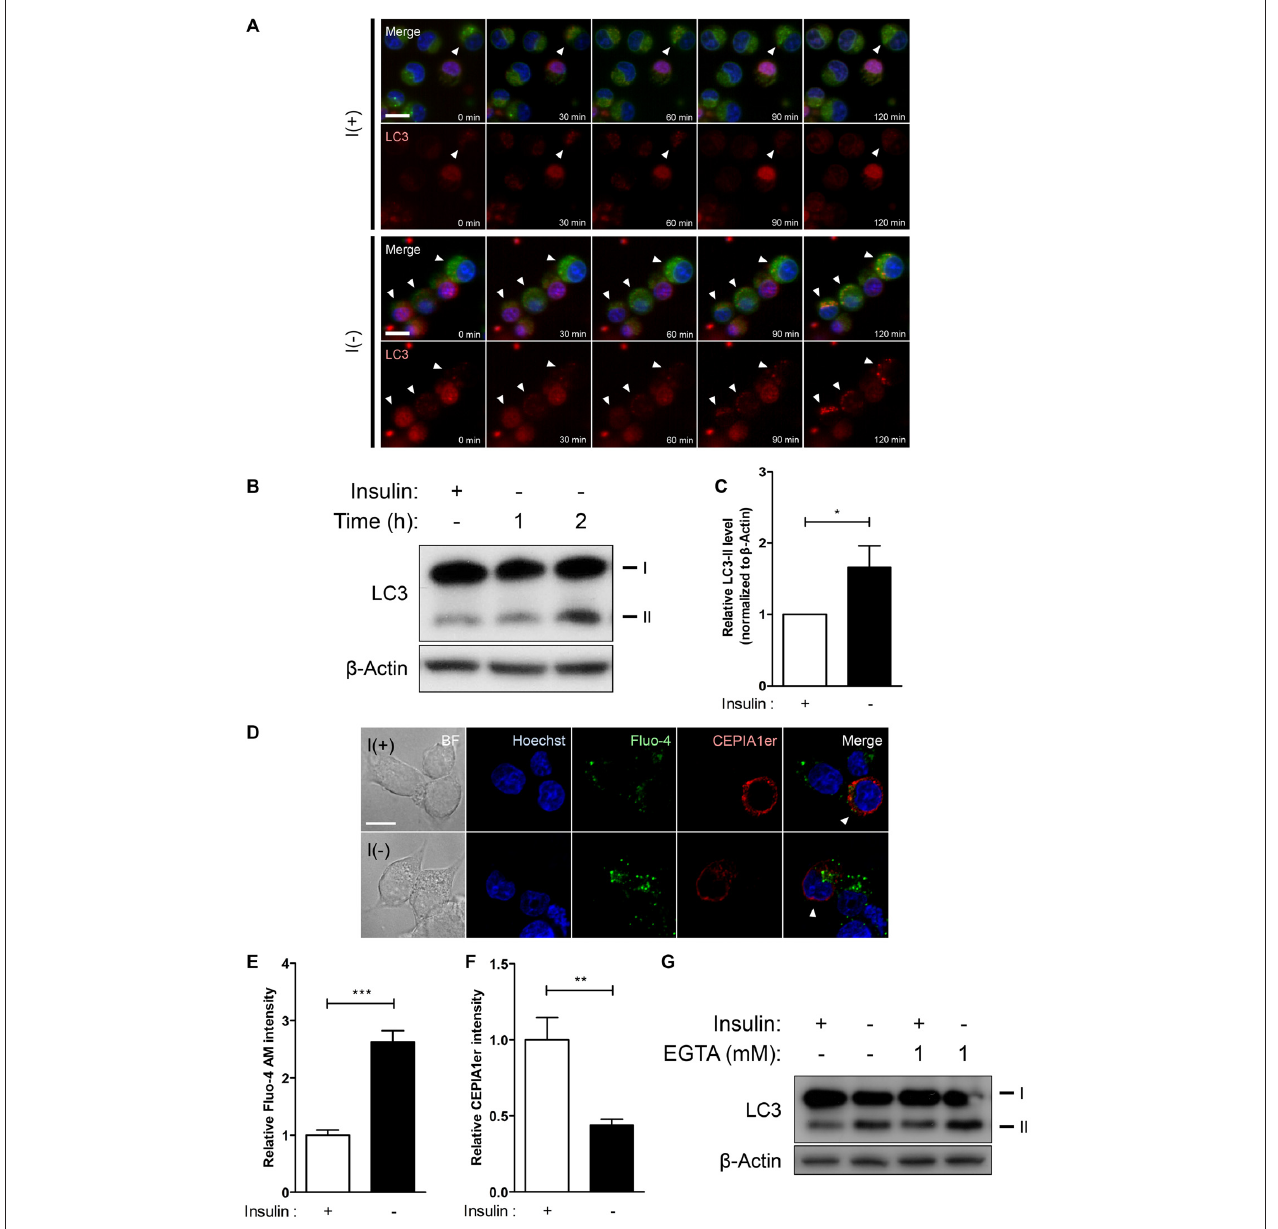
FIGURE 1 | Insulin withdrawal increases intracellular Ca 2 + levels without the involvement of extracellular Ca 2 + in hippocampal neural stem (HCN) cells. (A–C) Time-course of autophagic induction upon insulin withdrawal was assessed in HCN cells. (A) Live-imaging analysis of RFP-LC3-expressing HCN cells stained with Lysotracker Green. Cells indicated by arrowheads show LC3 puncta co-localized with lysosomes. Scale bar, 10 µ m. (B) Western blot analysis of HCN cells following insulin withdrawal for 1 h and 2 h. The signal intensity of LC3-II was quantified in (C) using the ImageJ software and normalized to β -actin ( n = 4). (D–F) Levels of intracellular and endoplasmic reticulum (ER) Ca 2 + in HCN cells were assessed using Fluo-4 AM and pCMV R-Ca 2 + -measuring organelle entrapped protein indicator 1 in the ER (CEPIA1er), respectively. (D) Immunofluorescence analysis of Fluo-4 AM and pCMV R-CEPIA1er in HCN cells under I(+) and I( − ) conditions for 24 h. Cells subjected to analysis are indicated by arrowheads. Scale bar, 10 µ m. Fluorescence intensities of Fluo-4 AM (E) and CEPIA1er (F) in HCN cells ( n = 30 for I(+), 36 for I( − )). (G) Western blot analysis of a biochemical marker of autophagy LC3 in HCN cells cultured in I(+) and I( − ) conditions with or without EGTA (1 mM) for 6 h. The bars represent the mean ± standard error of the mean (SEM); ∗ p < 0.05, ∗∗ p < 0.01, ∗∗∗ p < 0.001.